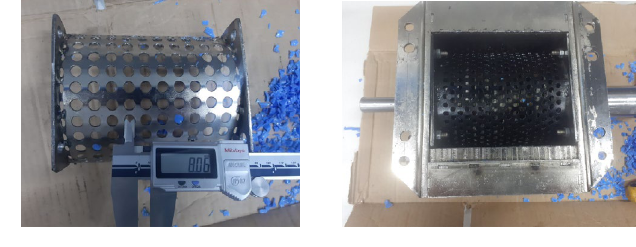
(a) Perforation hole size of 10 mm